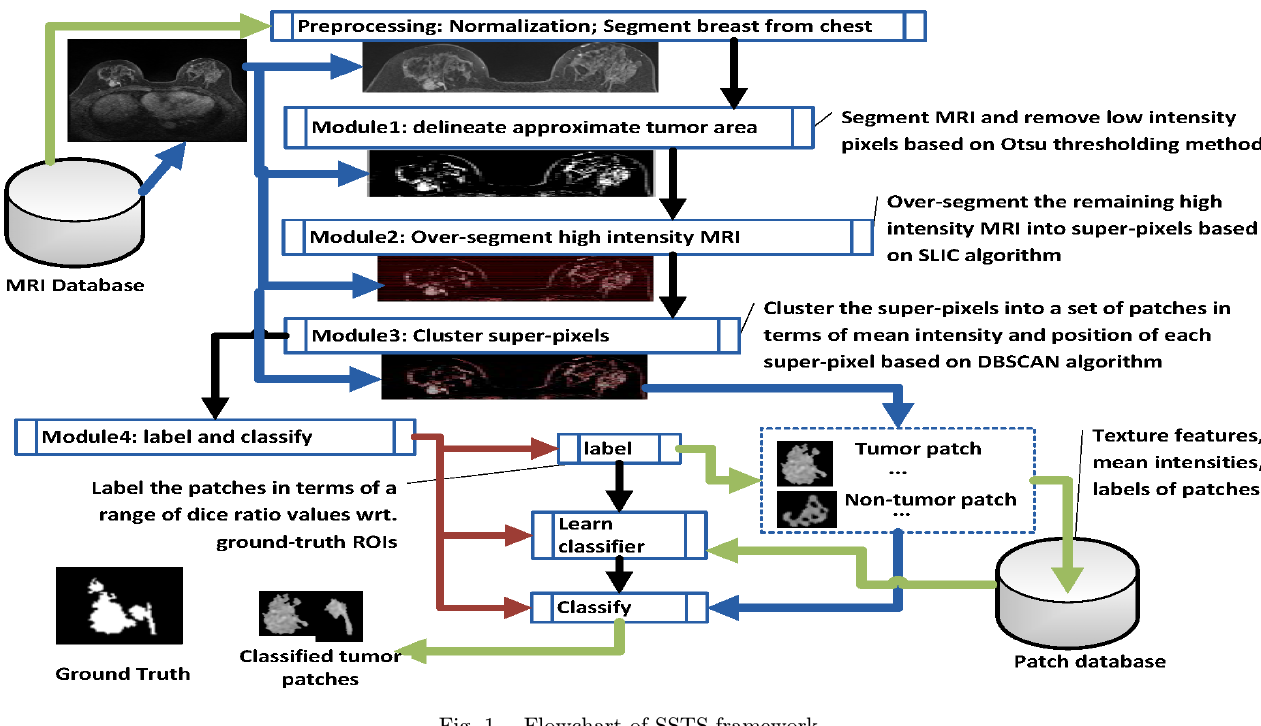
Fig. 1. Flowchart of SSTS